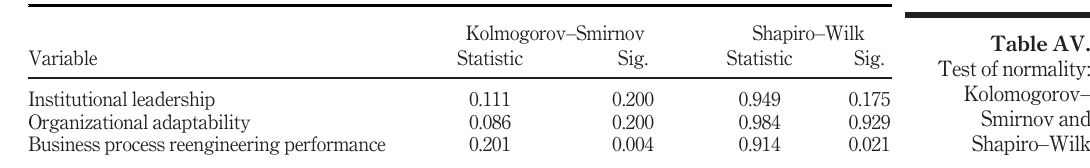
Table AV. Test of normality: